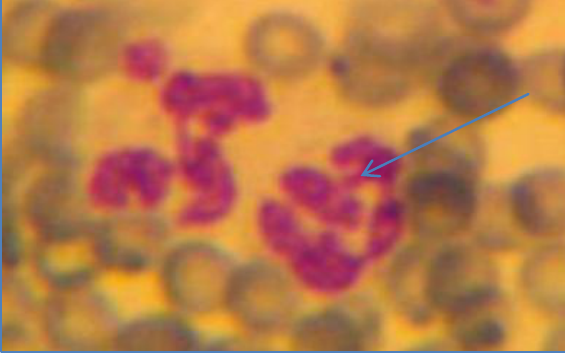
Figure, 4: Tear drop shape (1000